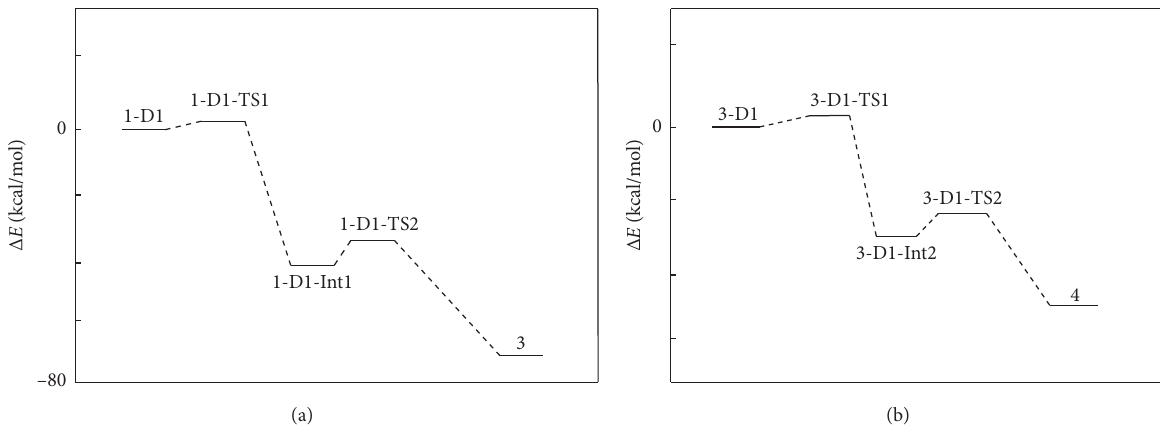
Figure 5: Proposed mechanisms for the DC reaction of benzodiazepine 1 and dipole D1 . (a) Approach 1. (b) Approach